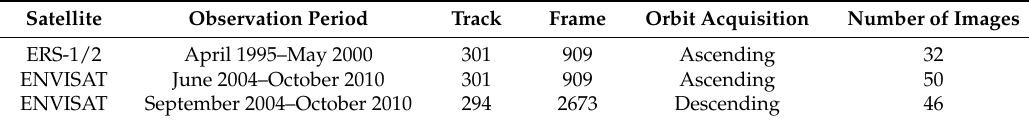
Table 1. Summary of the ERS-1/2 and ASAR Envisat images considered for the VDA study area. Satellite